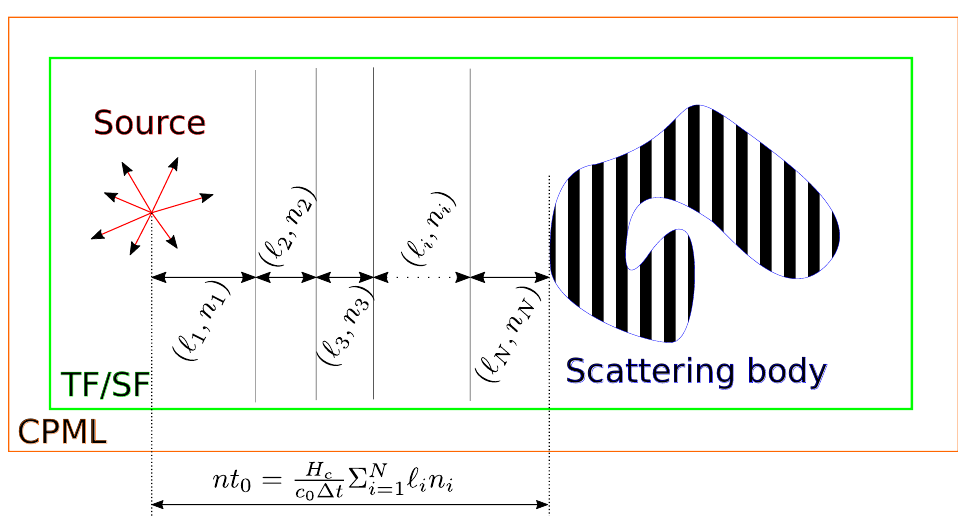
Figure 1. Scheme of the calculation box, illustrating the delay nt 0 ( k ) that depends on the refractive index of the media n i as well as the location of the electromagnetic field in the